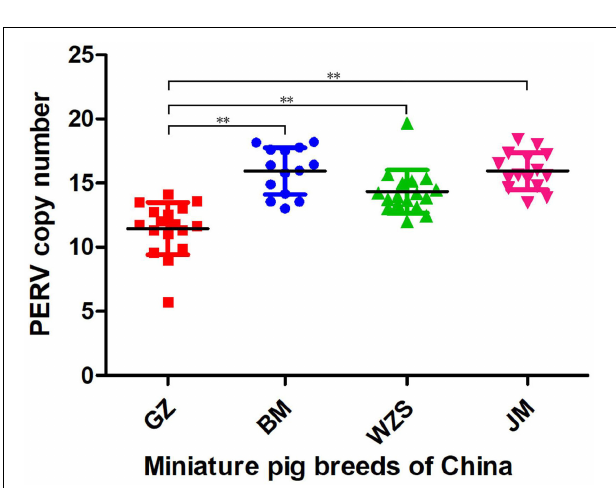
FIGURE 2 | The copy number of PERV in the four different miniature pig breeds from China is based on the ddPCR method. Each point indicates one animal. The median and the standard deviations are shown. Guizhou miniature pig (GZ, red), Bama miniature pig (BM, blue), Wuzhishan miniature pig (WZS, green), and Juema miniature pig (JM, pink). The symbols of significant difference between comparisons of different pig breeds was marked (** P <